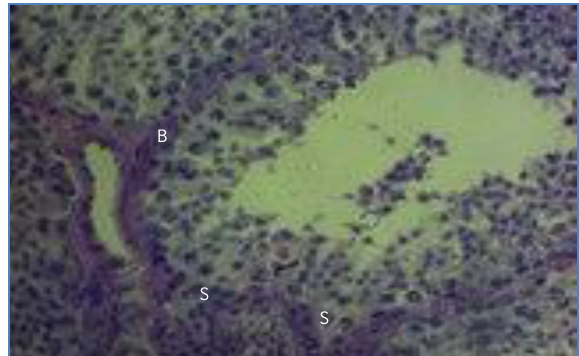
Figure, 2: Sertoli cells (S) and basement membrane (B) inside seminiferous tubules during autumn season. PAS X400.